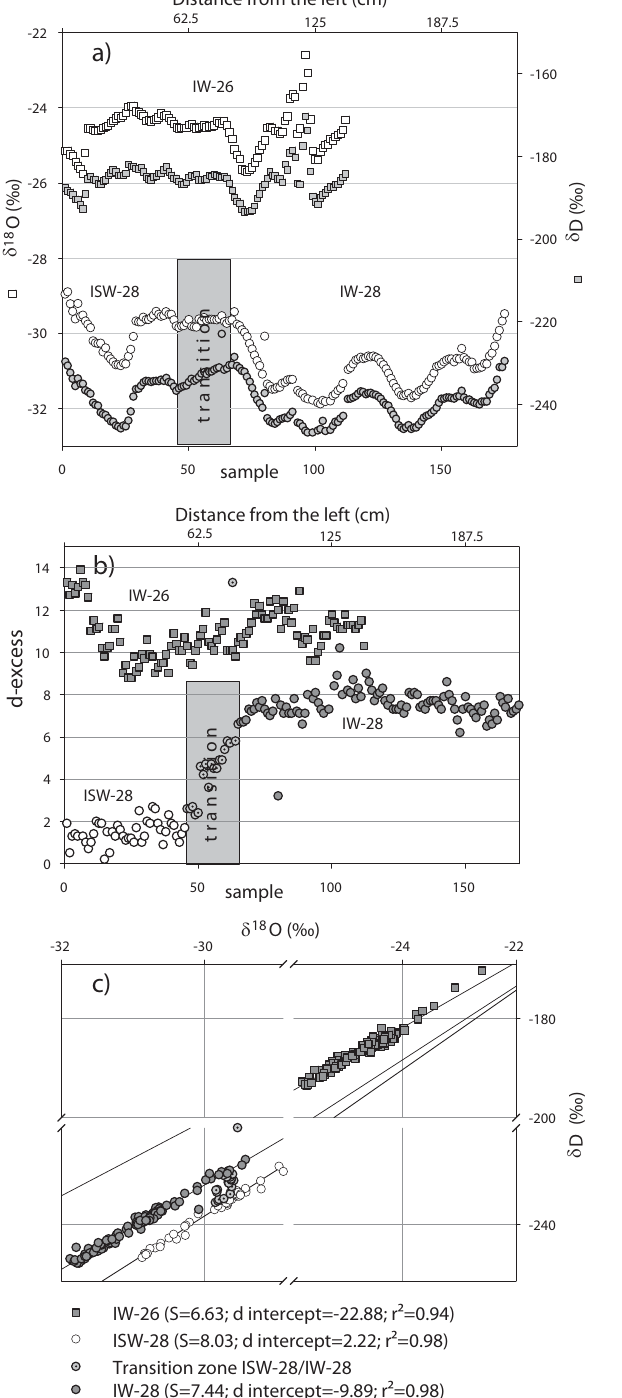
Fig. 4. Isotopic data for the two ice wedges: (a) δ 18 O and δ D pro- files, (b) d and (c) δ 18 O– δ D relationship. Numbers on the bottom x-axis of (a) and (b) refer to ice sample ordering, increasing from left to right, in the outcrop. The equivalent horizontal distance from extreme left is shown on the upper x-axis.